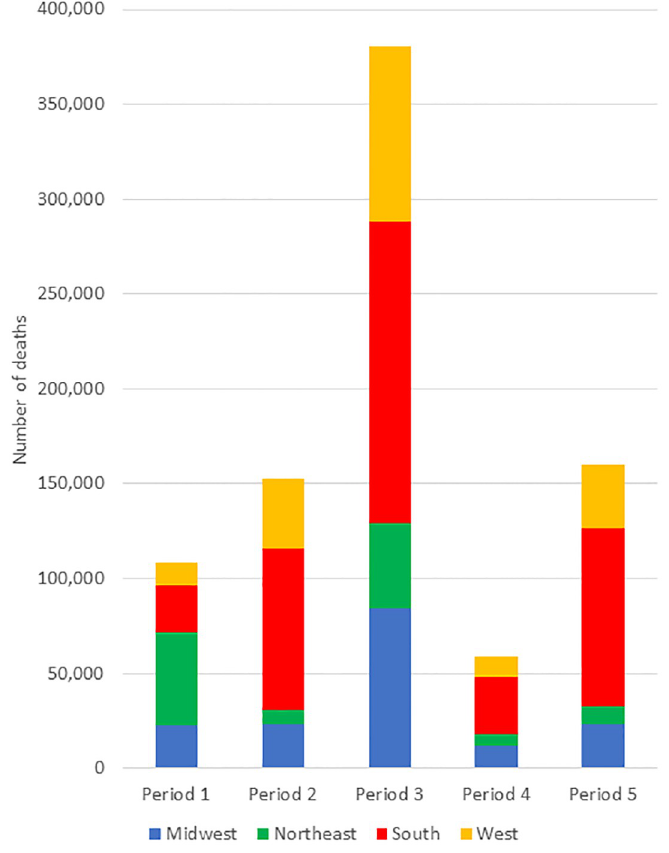
Fig 2. Number of excess deaths by period and region, U.S., January 3, 2020—September 26, 2021. The height of each bar represents the total U.S. excess deaths in each period and the colored sections represent the number of excess deaths in each region during the period. Periods are defined as follows: Period 1 (January 3 to May 30, 2020), Period 2 (May 31 –October 3, 2020), Period 3 (October 4, 2020 to February 27, 2021), Period 4 (February 28 to June 26, 2021), and Period 5 (June 27 to September 26, 2021). Source: authors’ calculations based on CDC